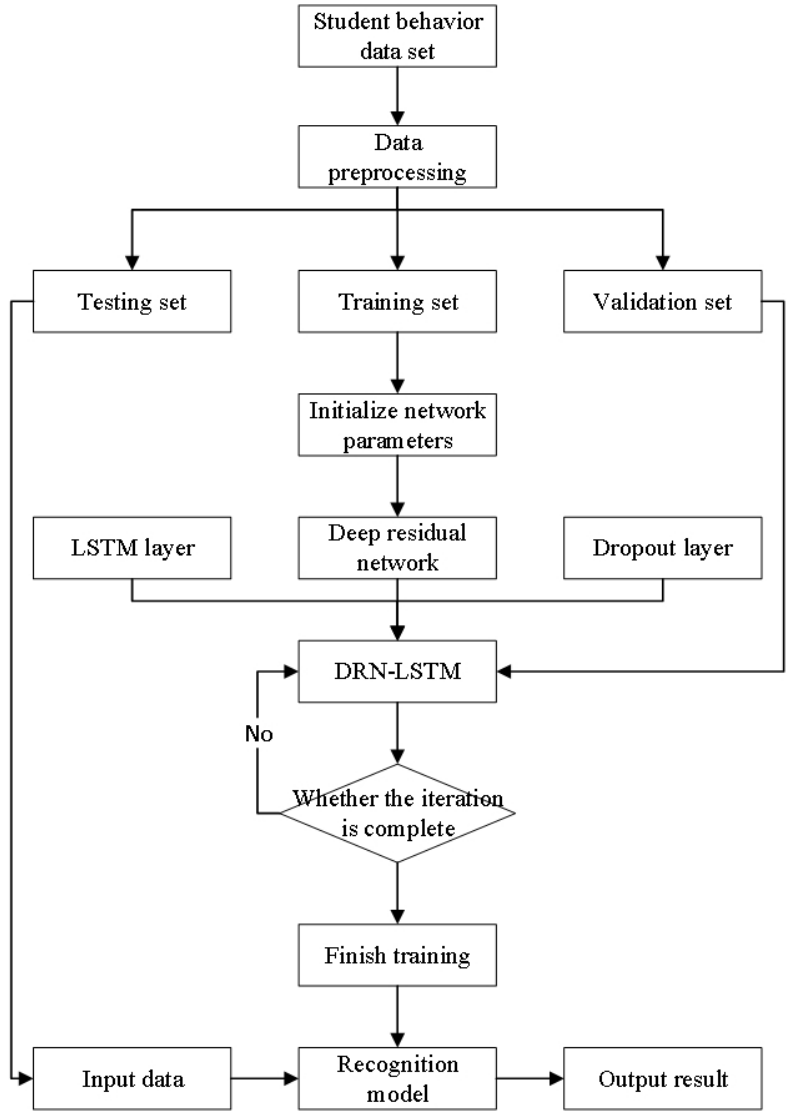
Fig. 5. Structure diagram of improved residual block